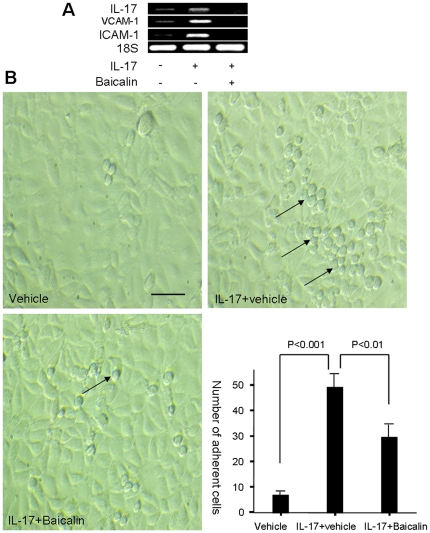
Baicalin inhibits IL-17 mediated gene expression of inflammatory molecules.(A) HUVEC was cultured in the presence of 50 ng/ml IL-17 in the presence or absence of Baicalin for 24 hours. Expression of the indicated genes was examined by RT-PCR. (B) HUVEC was stimulated in the presence of IL-17 with or without Baicalin for 24 hours. Jurkat cells were added for an additional 24 hours. After washing twice, the adhesive cells were counted under ×200 magnifications. Five independent microscopic fields were selected randomly for each sample to ensure representativeness and homogeneity. Results were expressed as mean ± SD. Arrows indicate the adhesive cells. Scale bar, 100 µm. These experiments were performed three times with similar results.